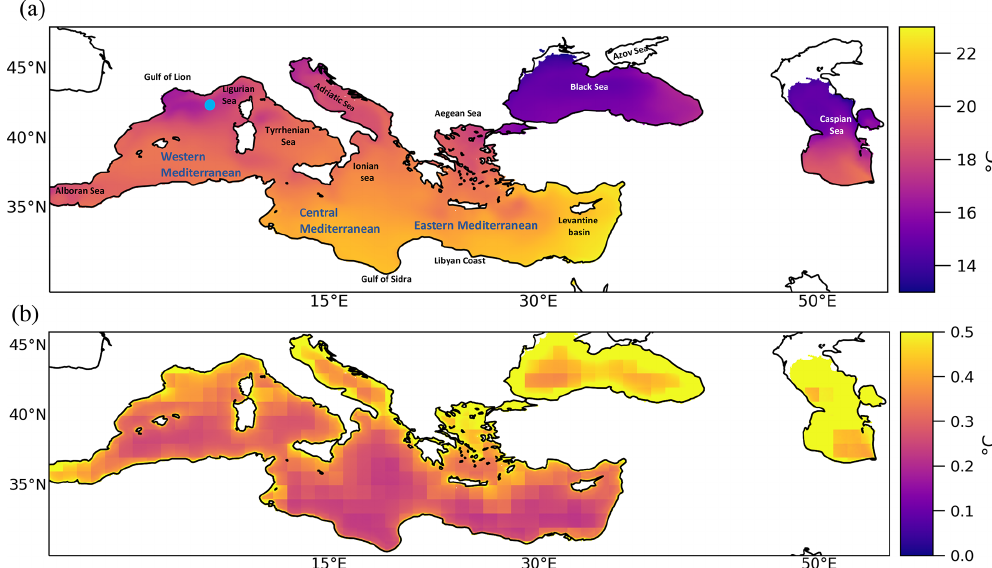
Figure 1. (a) Mean SST climatology detected by STL method with geographical names. The blue circle identifies the western Mediterranean location of the time series shown in Fig. 4. (b) The mean SST uncertainties during the studied